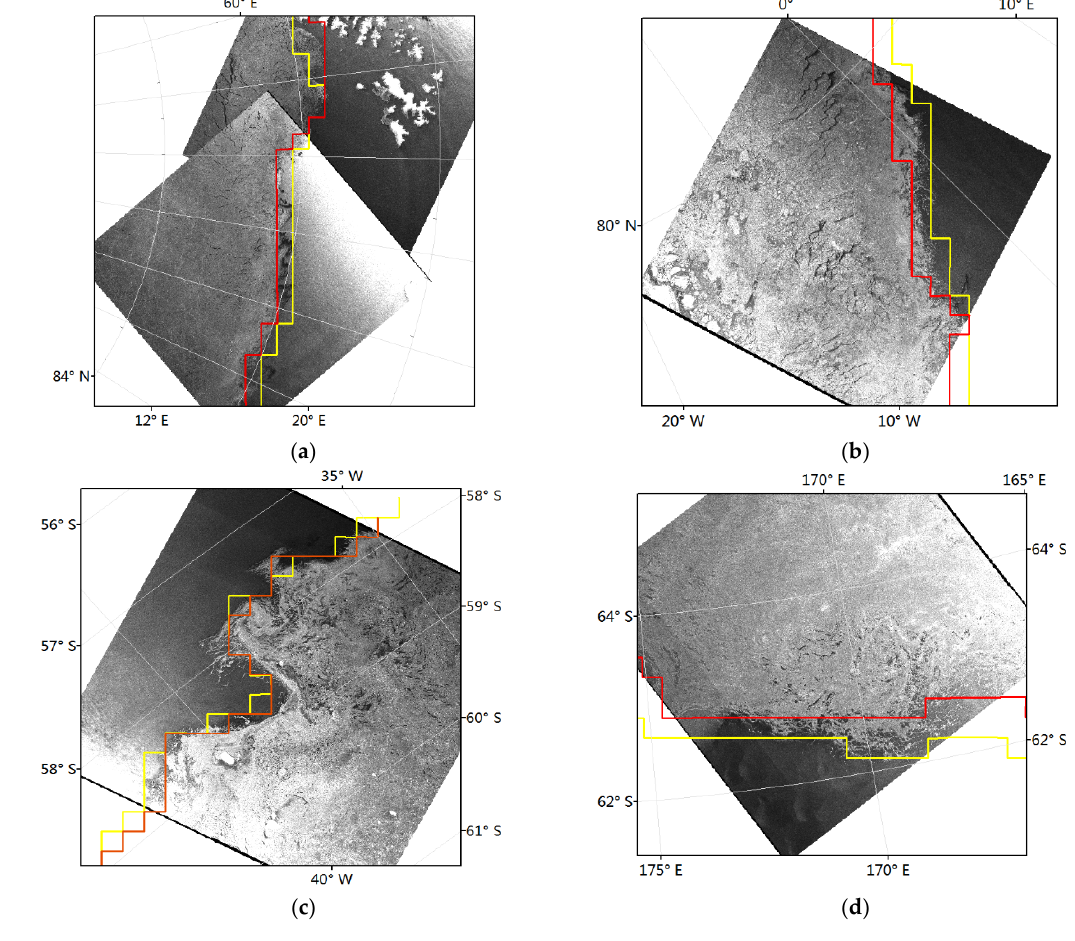
Figure 8. Sentinel-1 SAR images with HY-2A/SCAT ice edge (red) and SSMIS 15% sea ice contour edge (yellow) estimates. The acquisition time of the images are: ( a ) 23 October 2015, ( b ) 3 November 2015, ( c ) 29 September 2015 and ( d ) 20 October 2015.